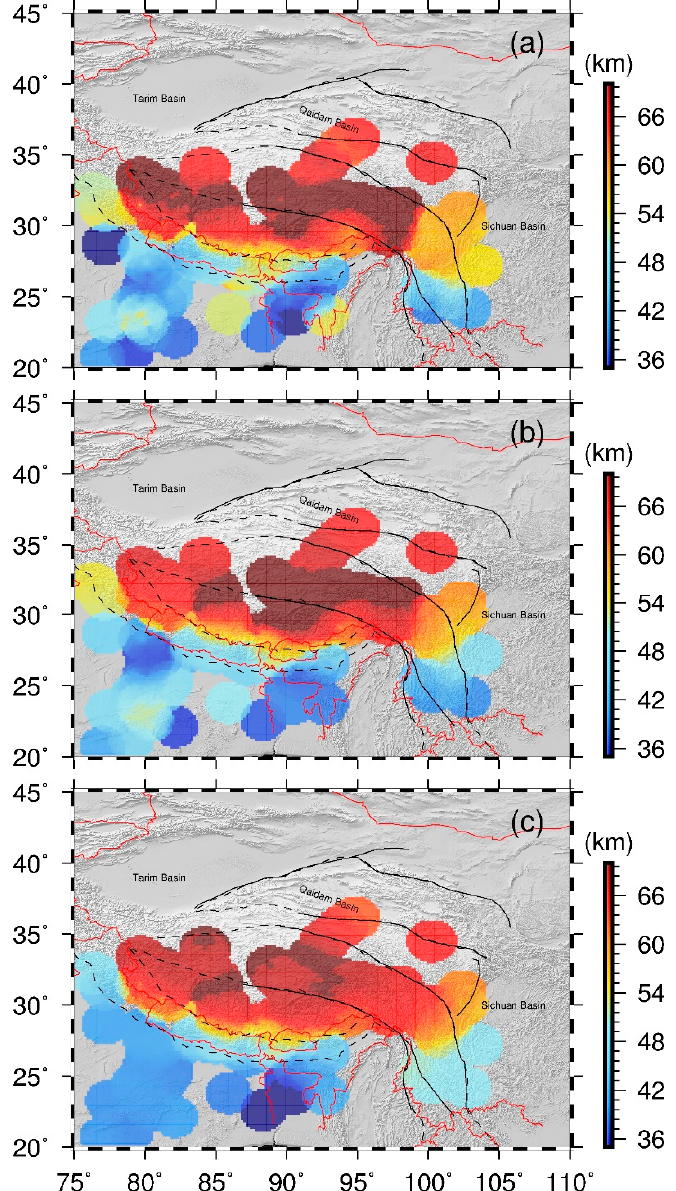
Figure 6. Crustal thickness from ( a ) Singh et al. (2017) [59], ( b ) CRUST1.0, ( c ) MJ.